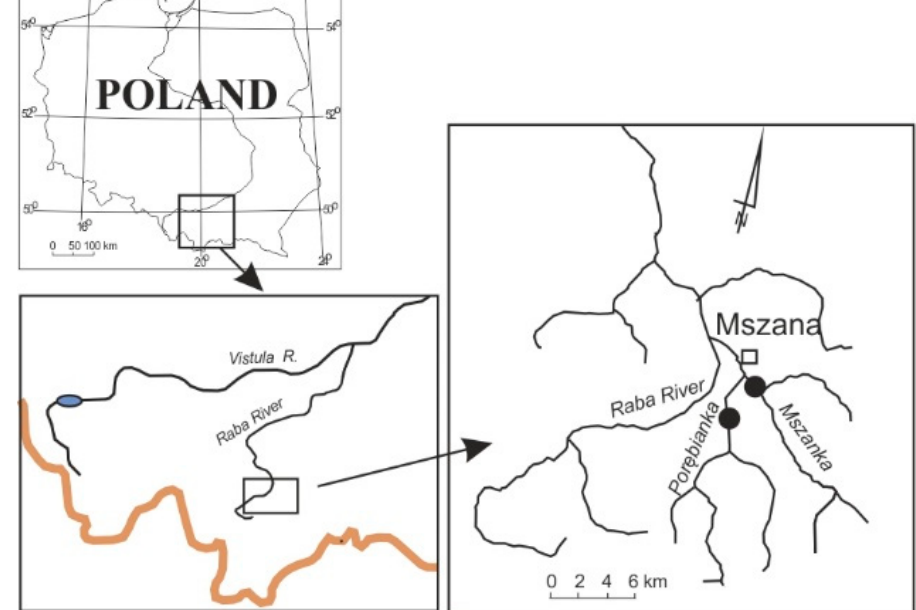
Figure 1. Location of the study site.